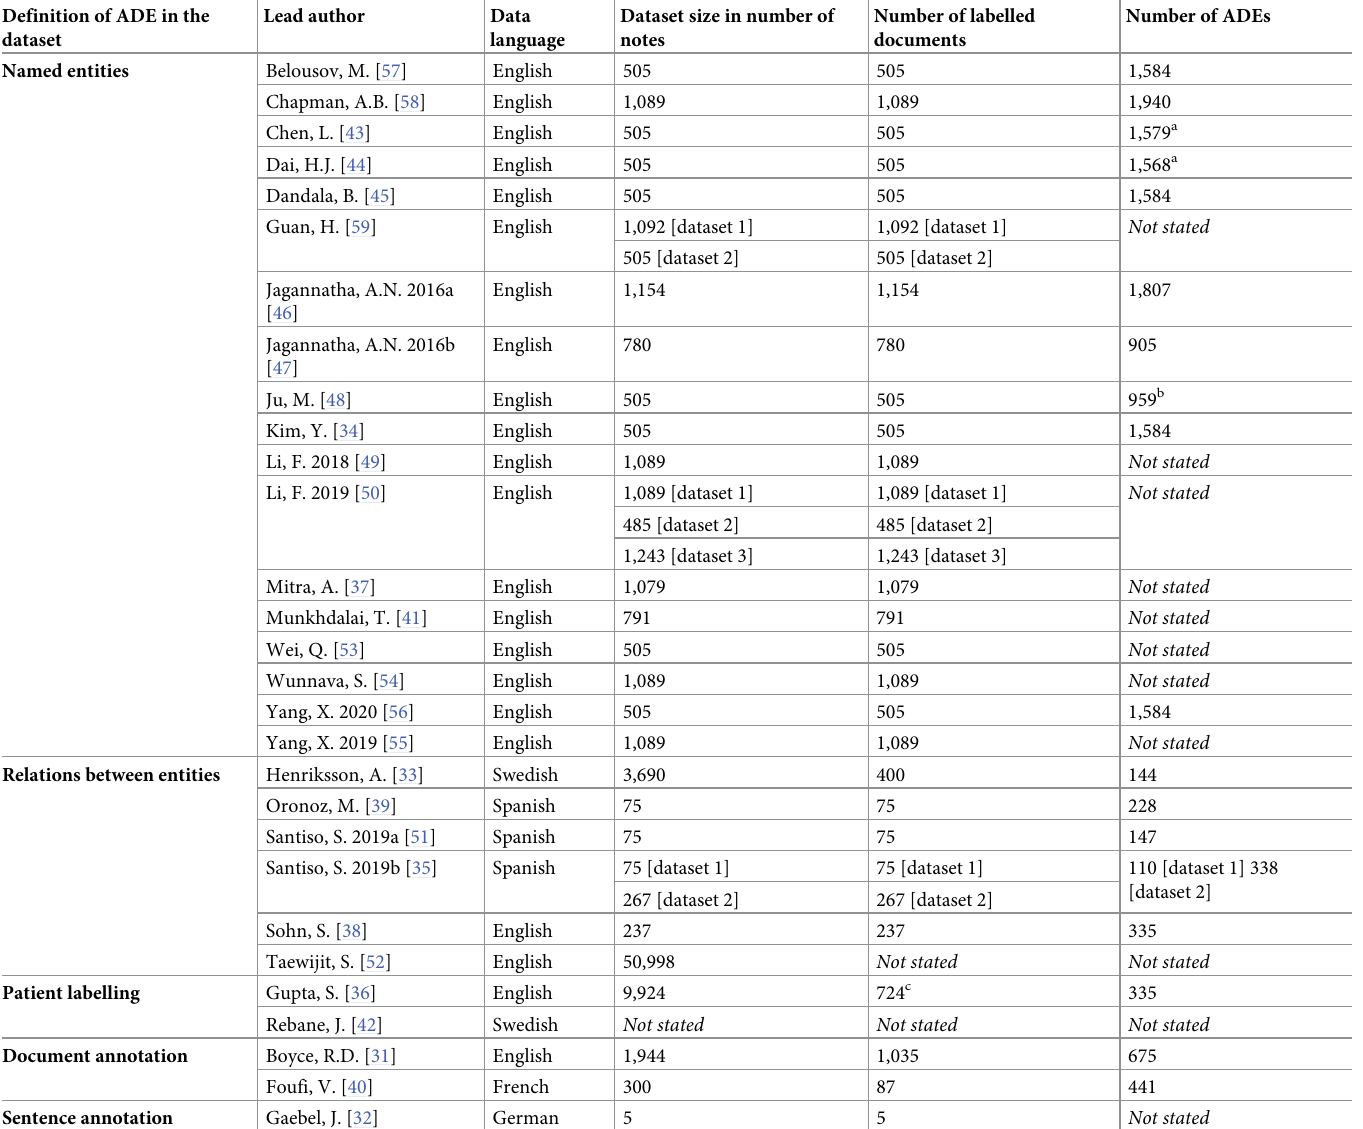
Table 3. Dataset